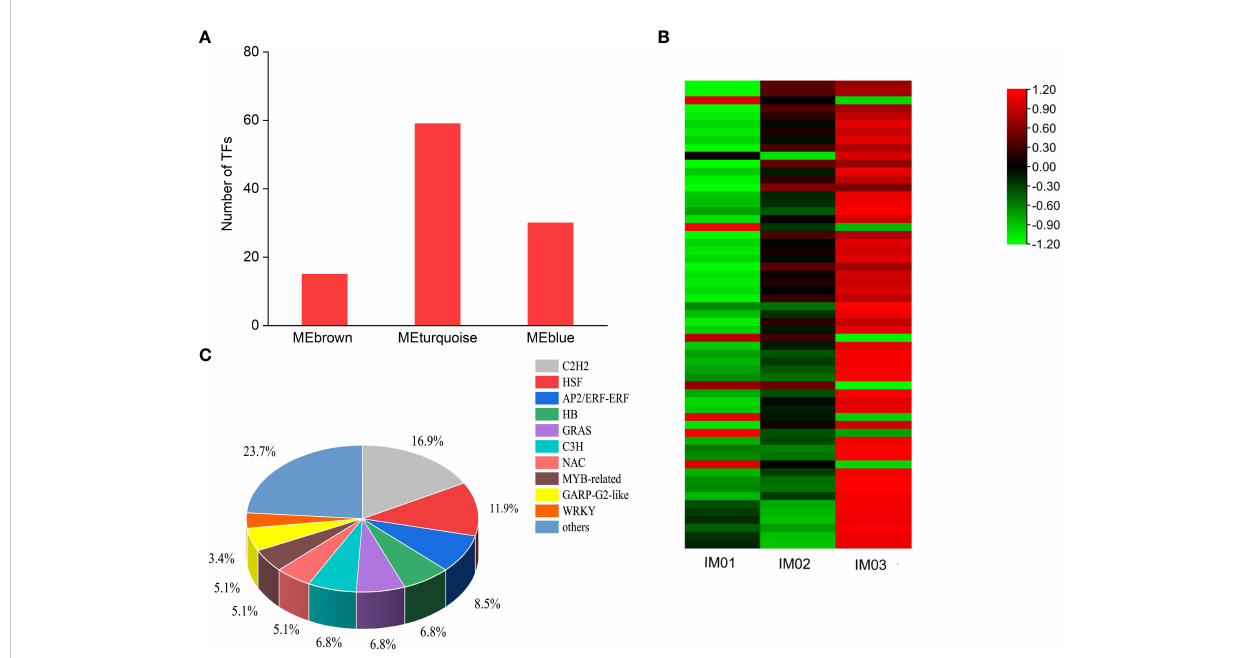
FIGURE 8 TFs analysis based on WGCNA. (A) . TFs in the MEbrown, MEturquoise, and MEblue modules. (B) . Heatmap of TFs in the MEturquoise module. (C) . Classi fi cations and proportions of TFs in the MEturquoise